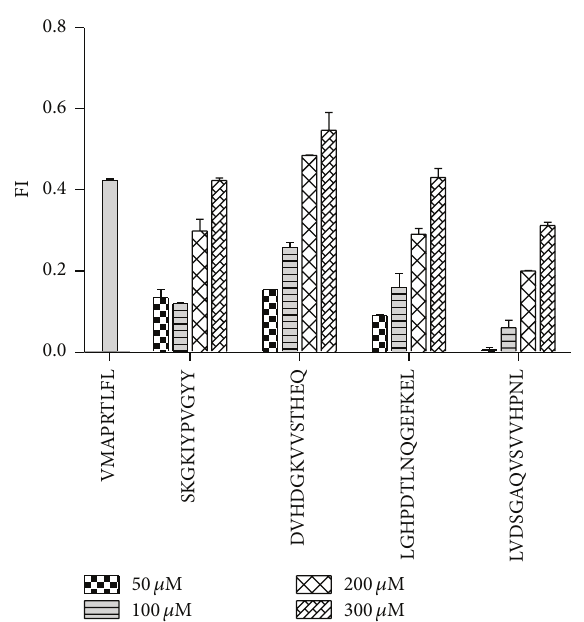
Figure 1: Noncanonical peptides stabilize HLA-E surface expres- sion. The T2 cell line transduced with the HLA-E ∗ 01:01 allele was incubated in the presence or absence of the indicated peptides at 37 ∘ C for 2.5 hours prior to staining with the mab 3D12 (anti-HLA- E) and analyzed by flow cytometry. Each peptide was titrated with the indicated concentrations and compared to a known HLA-E peptide ligand VMAPRTLFL that was carried along with a saturated concentration of 200 𝜇 M indicated by the difference in median fluorescence intensity between T2E cells in the presence of peptide ± SEM of at least two individual experiments. FI values from T2E cells in the absence of peptide were subtracted from experimental samples as background